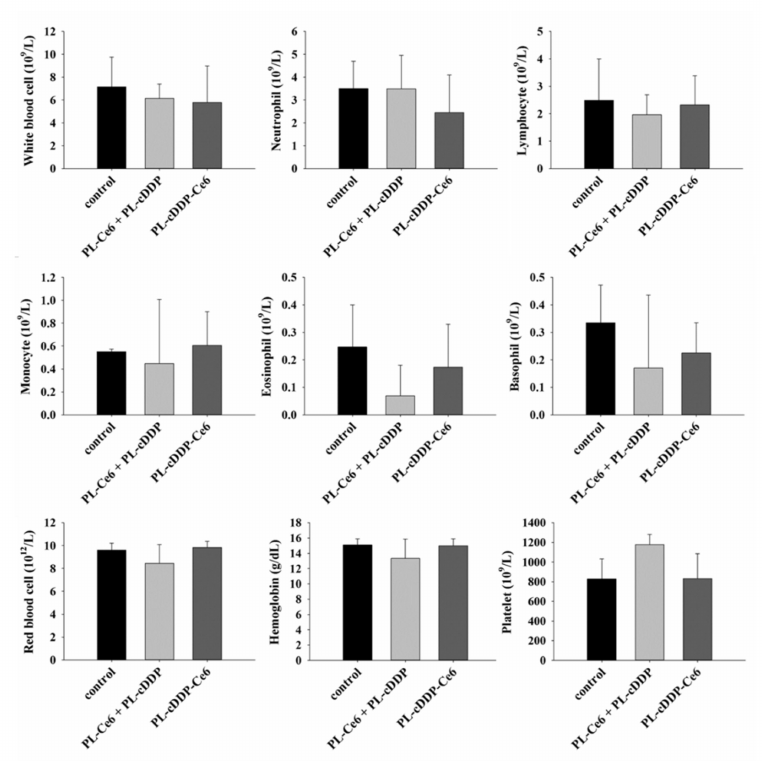
Figure 6. Hematology assay of white blood cells, neutrophil, lymphocytes, monocyte, eosinophil, basophil, red blood cells, hemoglobin and platelets 3 days post the treatment of PL-cDDP-Ce6 or PL-cDDP and PL-Ce6 in